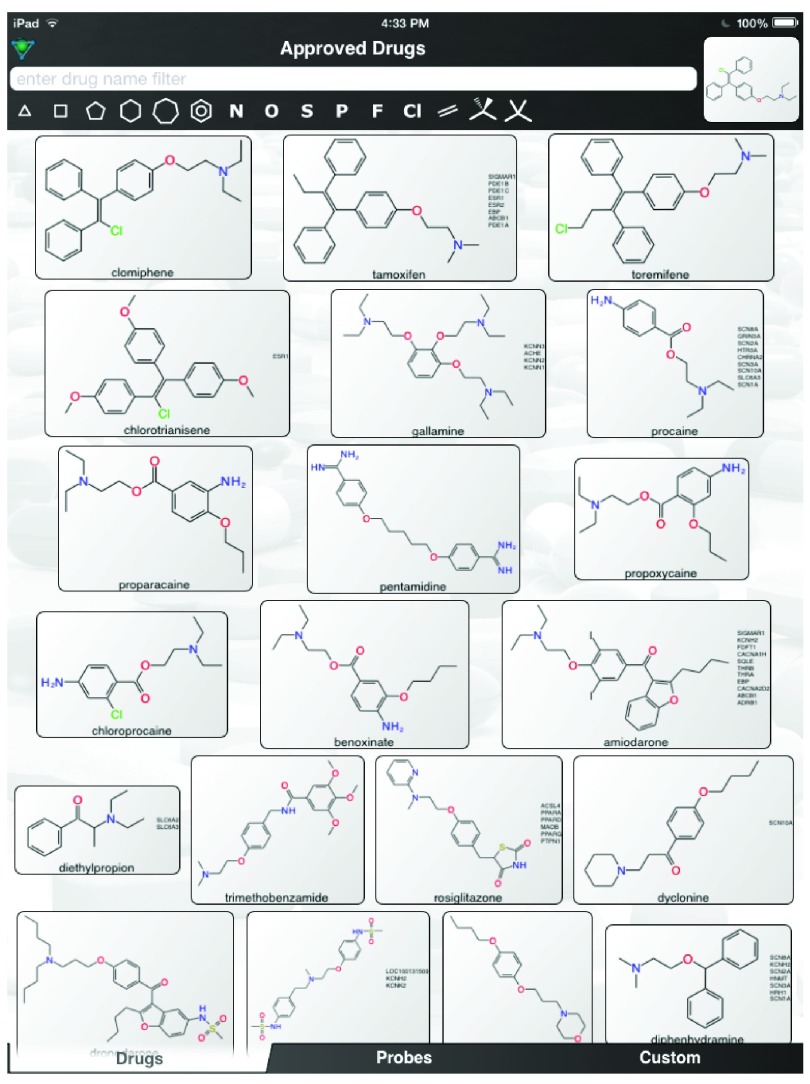
Clomiphene similarity in Approved drugs mobile app
http://molmatinf.com/approveddrugs.html.